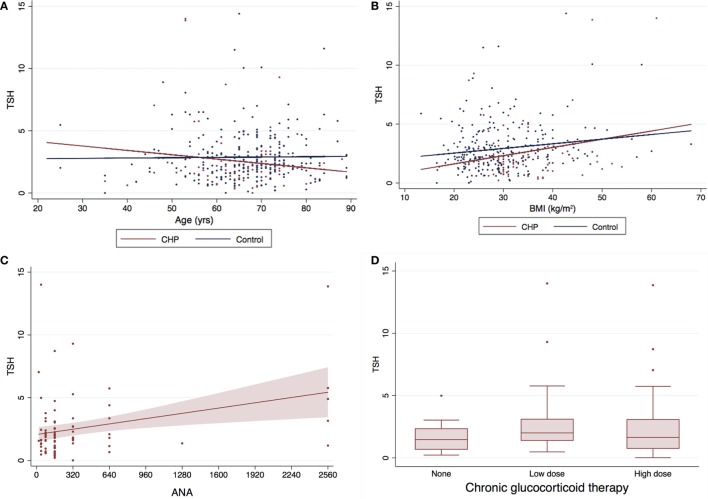
Serum TSH levels and baseline characteristics of CHP cohort*. The mean TSH for the CHP cohort was marginally lower (0.53 mIU/L) than the control population (2.52 ± 2.47 vs 3.05 ± 2.78; P = 0.121). There was no correlation between (A) TSH and age (R = −0.036, P = 0.502) or (B) TSH and body mass index (BMI) (R = 0.086, P = 0.115). Serum TSH levels (C) correlated positively with antinuclear antibody (ANA) titers (R = 0.2997; P = 0.0043), and (D) did not differ with/without glucocorticoid therapy (P = 0.497). Panel (C) only includes patients with CHP and no controls. *Two data points with TSH >20 included in the analysis were not depicted in the graph above for the purpose for clarity. TSH, thyroid-stimulating hormone; CHP, chronic hypersensitivity pneumonitis.